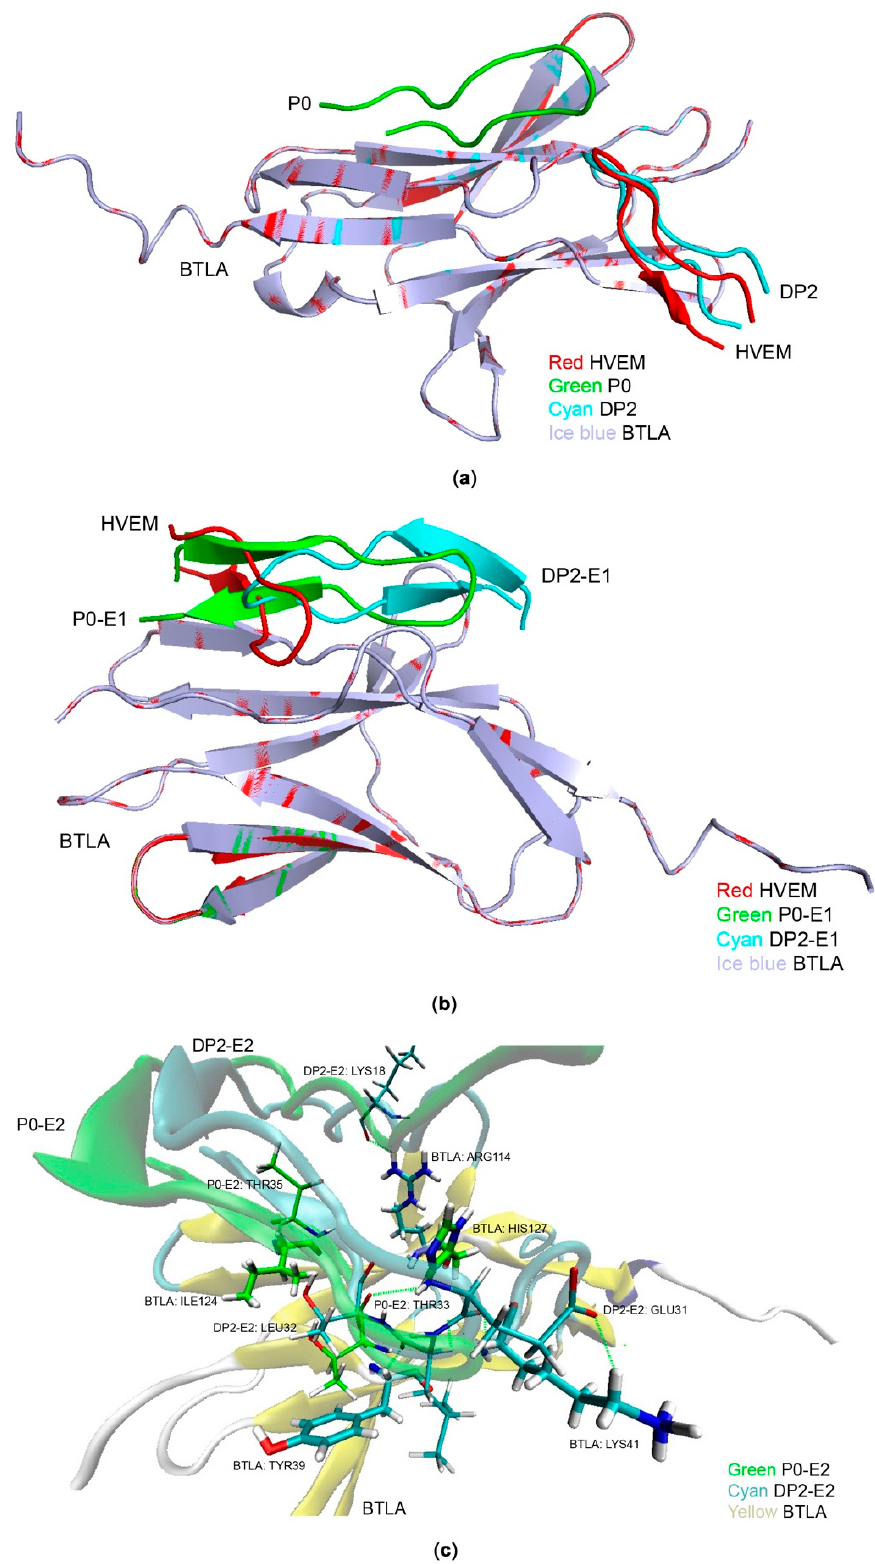
Figure 4. Docking results showing the predicted interactions between the native or mutated peptides and BTLA. ( a ) P0 binds to a different site on BTLA from HVEM but DP2 binds on the same site as HVEM. ( b ) P0-E1 and DP2-E1 bind on the same site as HVEM but with various orientation. ( c ) P0-E2 and DP2-E2 bind at the same site on BTLA, the latter with more hydrogen bonds